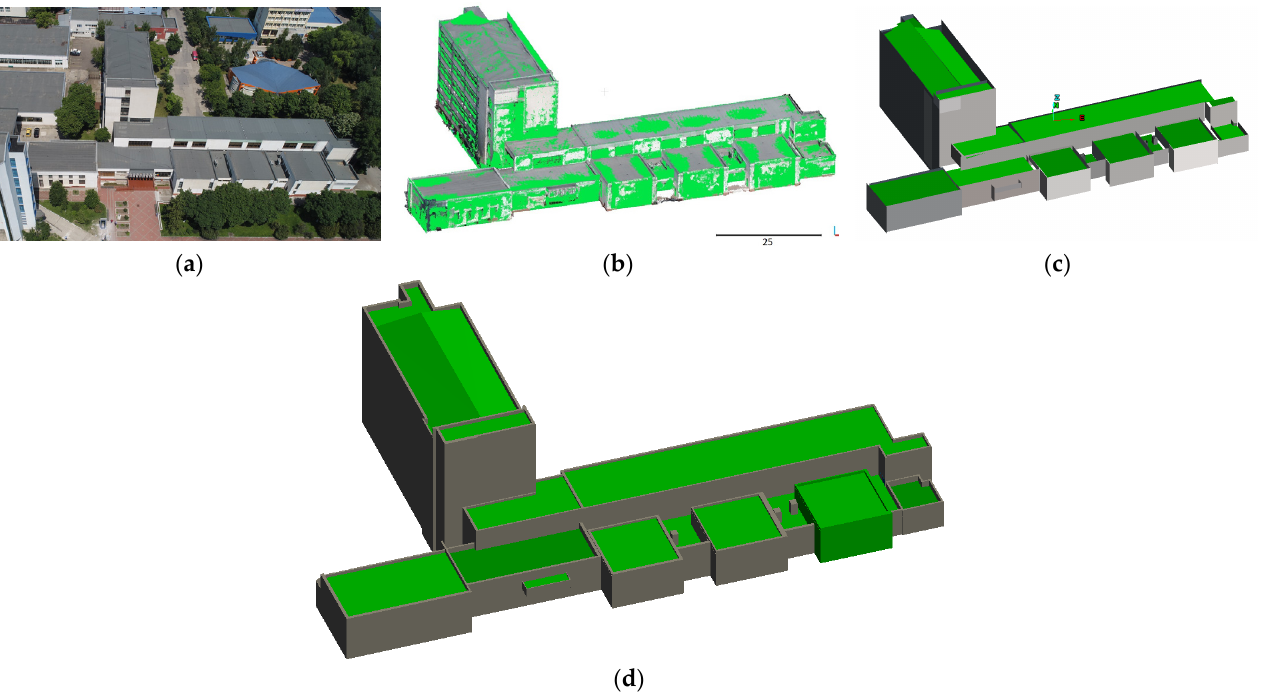
Figure 27. ( a ) UAS image of the rectory building, ( b ) the corresponding planes of the building integrated into the UAS point cloud, ( c ) the building planes for further editing, ( d ) detailed model of a building determined by piece ‐ wise intersection of planar faces.